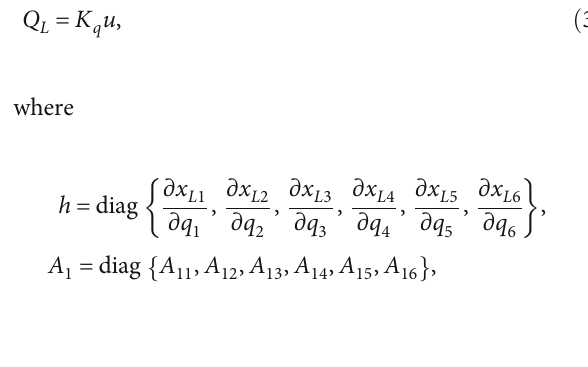
at the back, and (d) parameter estimation of Δ 1 n